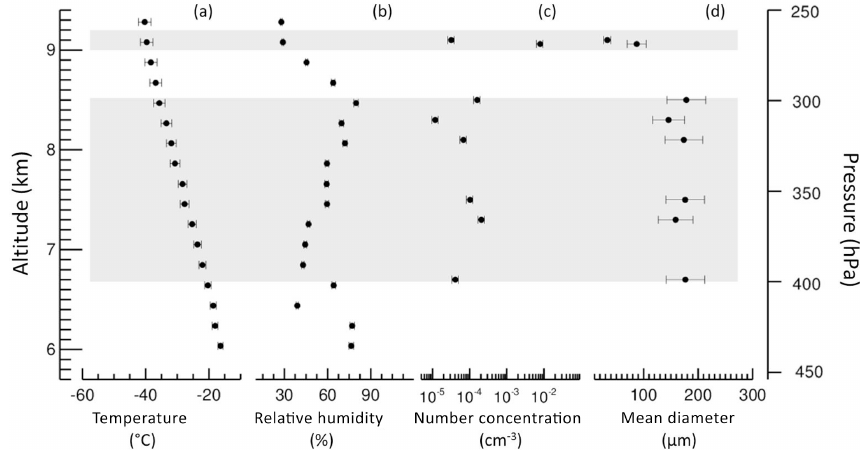
Figure 5. Vertical profiles of (a) temperature, (b) relative humidity, measured on the Learjet 35A, (c) number concentration, and (d) mean diameter, derived by CIPgs on AIRTOSS, from the flight of 30 August 2013. The bars show the corresponding measurement uncertainties. The gray areas indicate the vertical extent of the cirrus